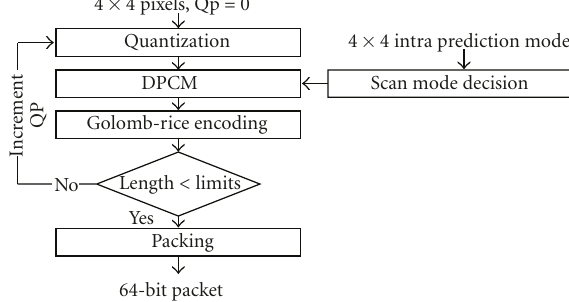
Figure 3: Flowchart of the proposed FMC